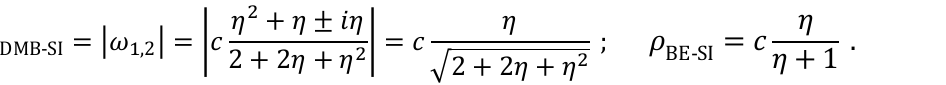
Figure 1. (Color online) Illustration of TDMB forward ( 𝝁 nodes, the hollow red nodes are solved at each step. Vertical and horizontal broken lines indicate the cell - and time -